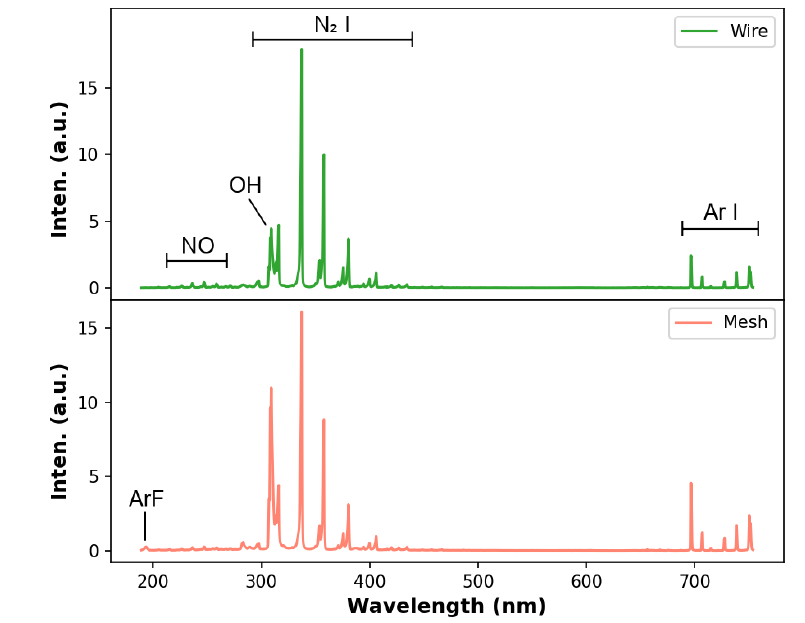
Figure 5. Overview of the emission spectra of the plasma jets obtained using wire ( top ) and mesh ( bottom ) configurations. The distance between plasma outlet and target was 6 mm and the gas flow rate was 2.0